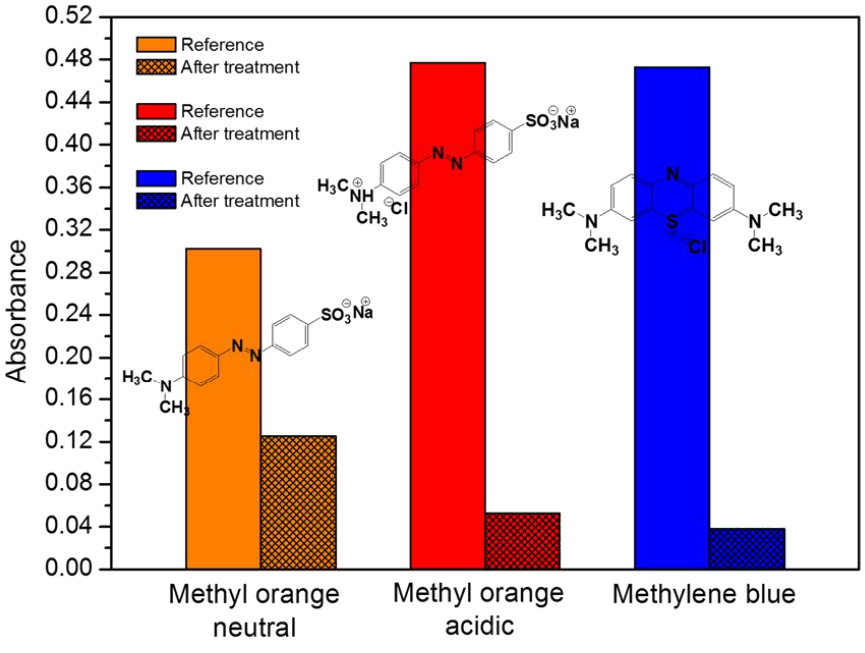
Figure 4. Evaluation of the efficiency of the magnetite-carbon nanocomposite for the removal of organic dyes.